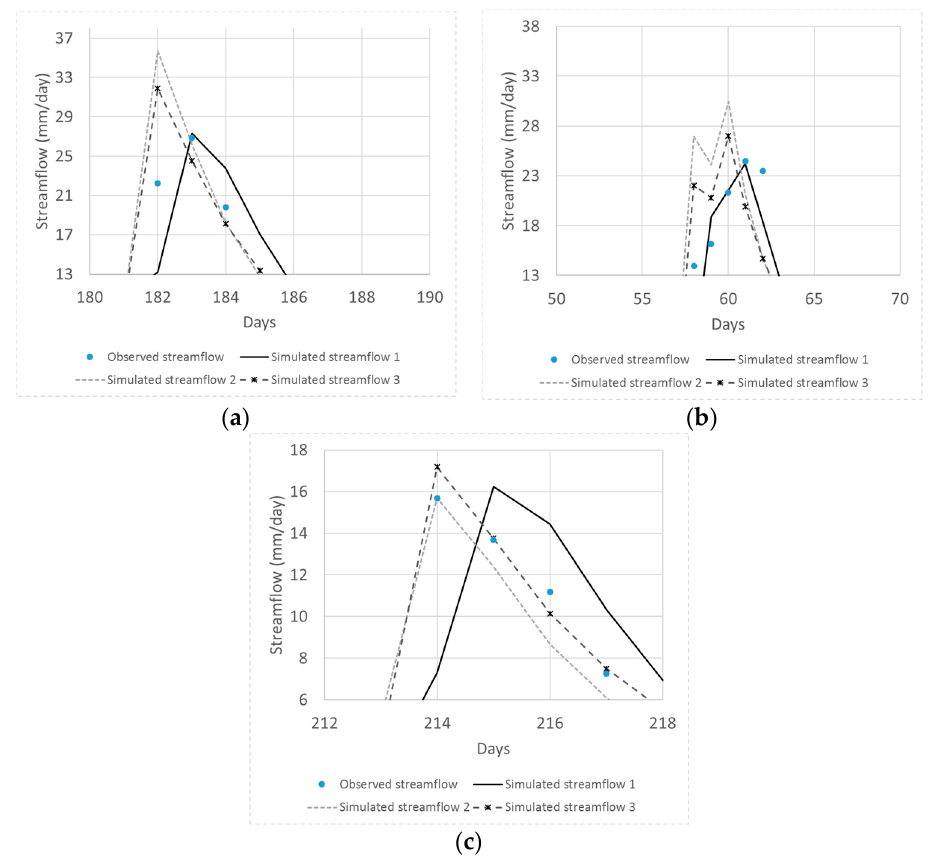
Figure 12. Closer view of the hydrograph of the three peak flows in Figure 11: ( a ) Peak 1; ( b ) Peak 2; and ( c ) Peak 3.